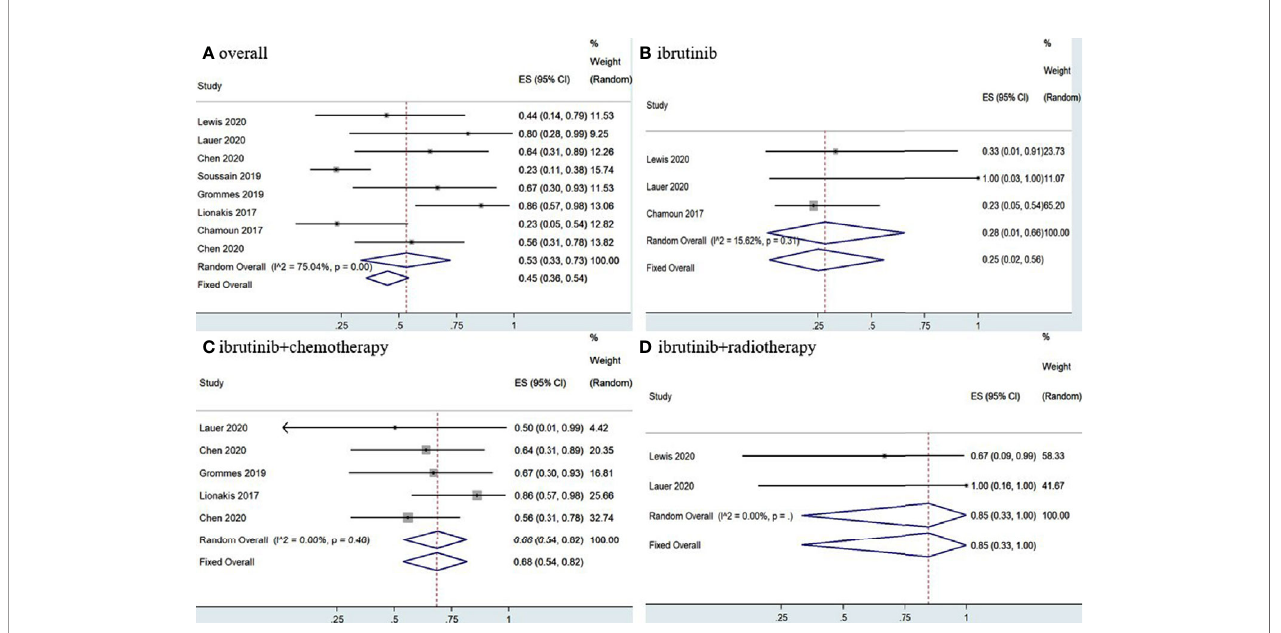
FIGURE 5 | Pooled complete response rates of primary central nervous system lymphoma. (A) Ibrutinib-based regimens. (B) Ibrutinib monotherapy. (C) Ibrutinib combined with chemotherapy. (D) Ibrutinib combined with